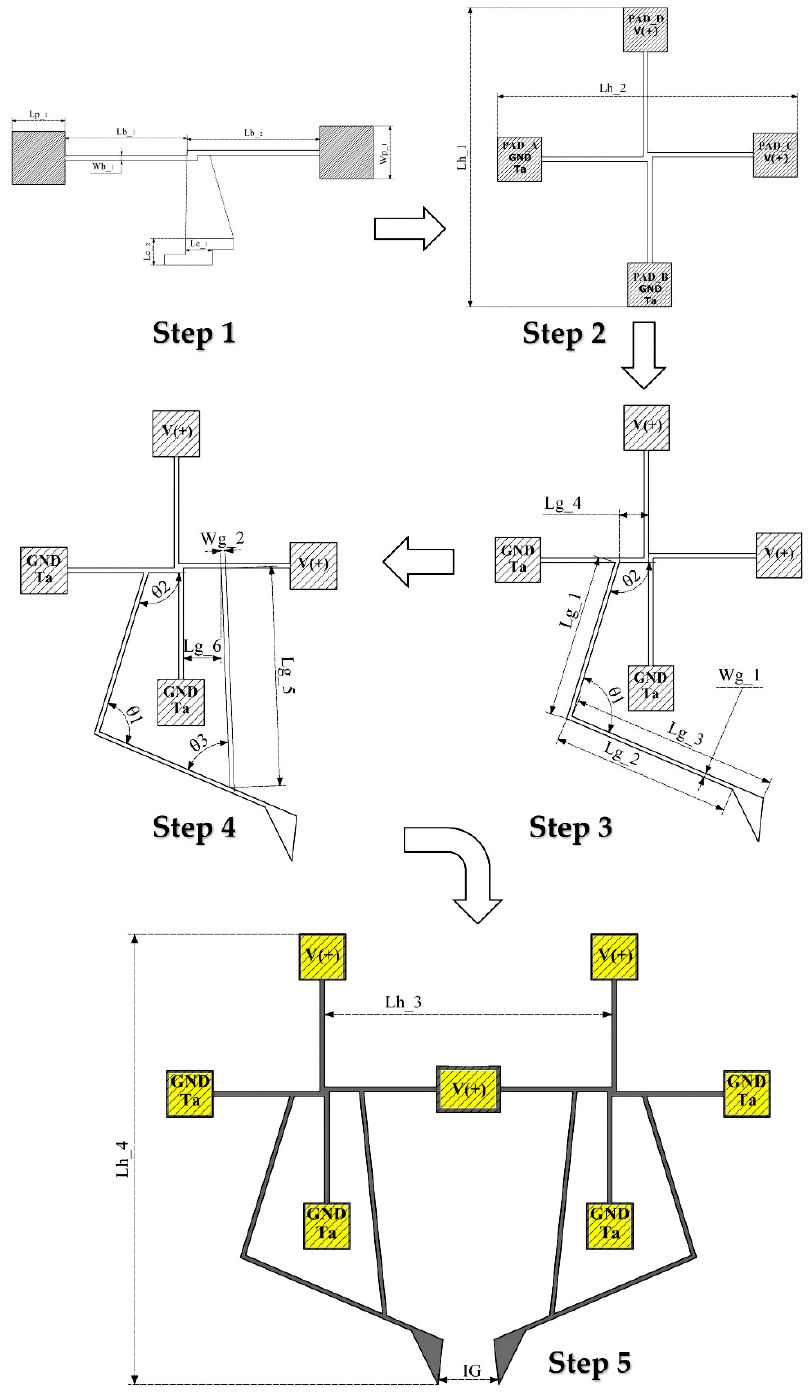
Figure 1. Design flow of the normally open electrothermal microgripper Model 1, considering the evolution steps of the schematic diagram.